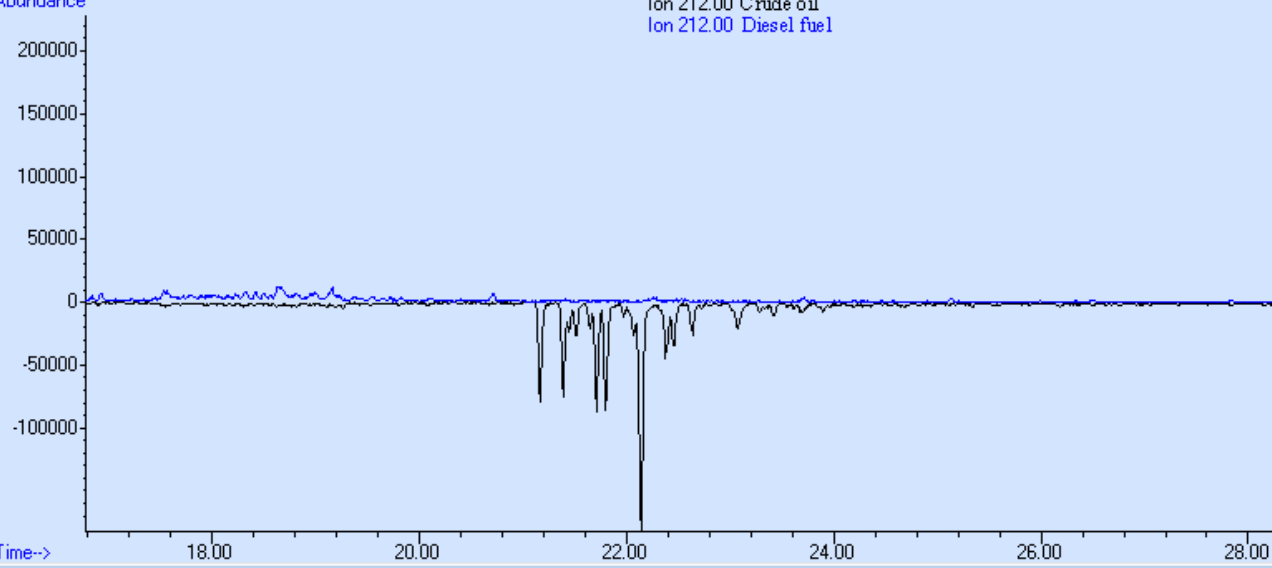
Figure 9. Comparison of EIC at m/z 212 between crude oil and diesel fuel samples.